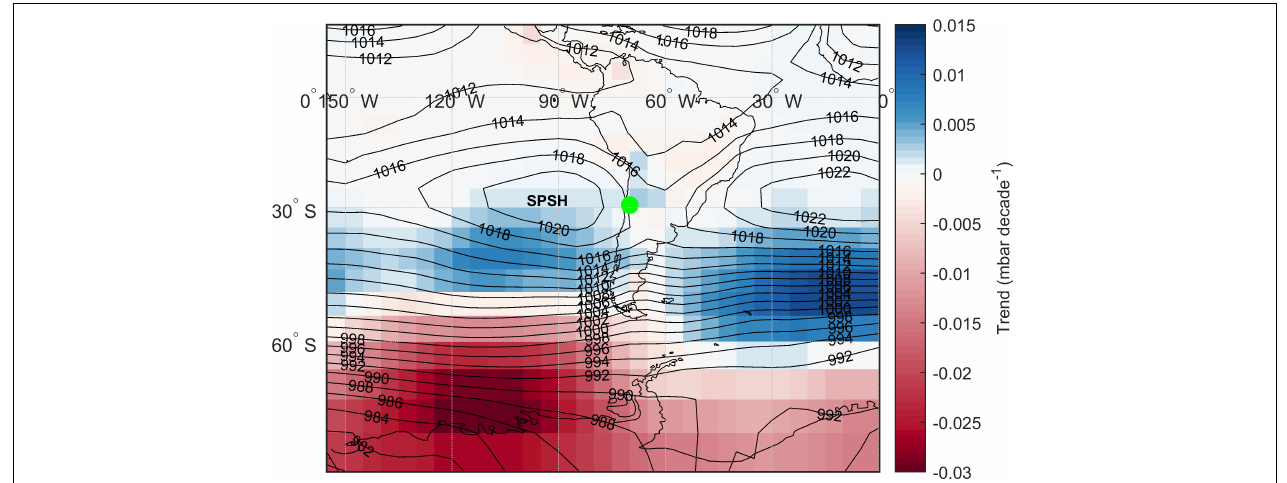
FIGURE 12 | Mean sea-level pressure (SLP) patterns during winter (JJA) over South America (black isobars), and linear trends in SLP (color scale) over the 1905–2012 period. SPSH, South Pacific Subtropical High; Green dot: Guanaco